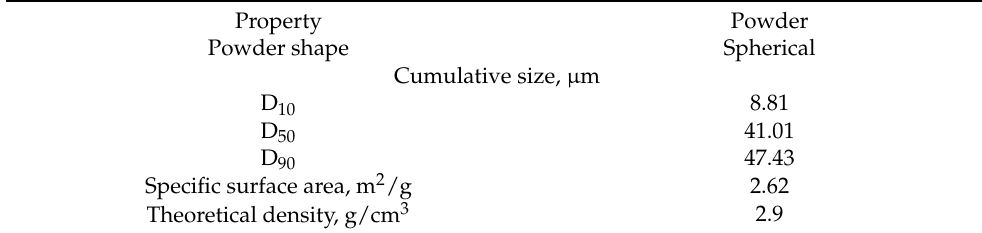
Table 2. Characteristics of fly ash powder used in the study.